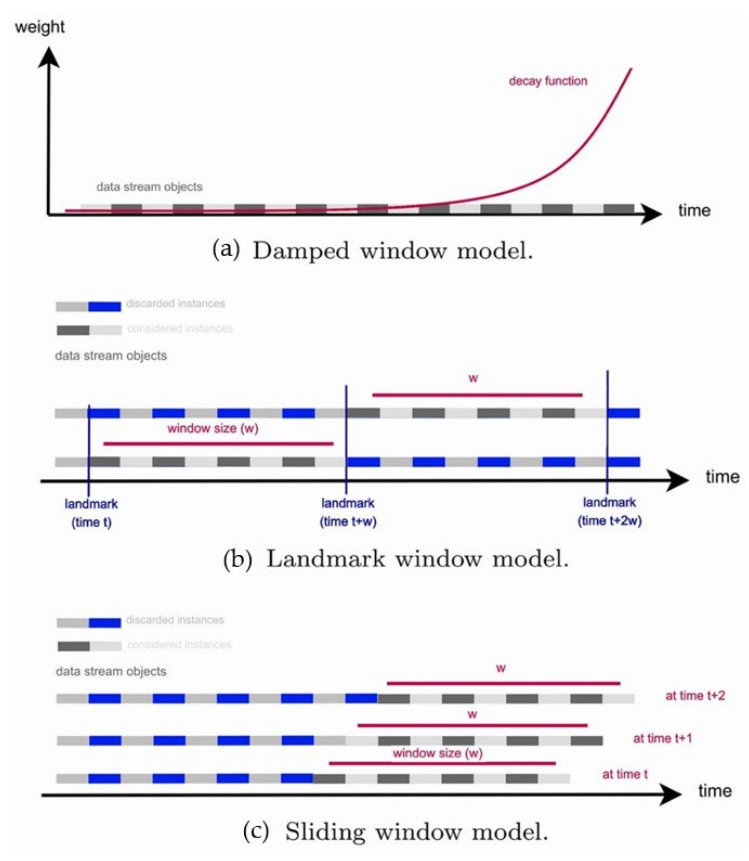
Figure 7. Window